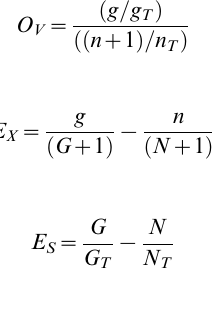
Table S2 The list of genomes in the human gut-related (HGR) and human gut-unrelated (HGU) sets. Table S3 The list of 182 curated new families specific to the human gut